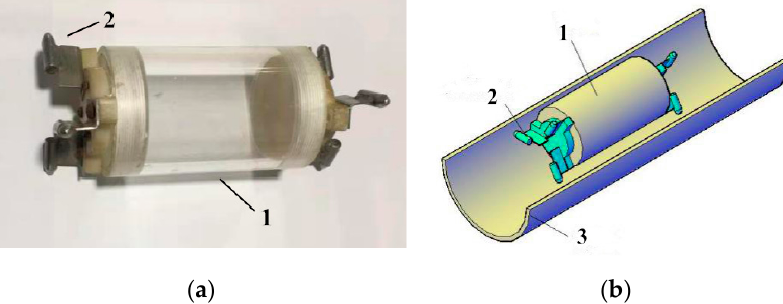
Figure 2. Schematic of pipe vehicle. ( a ) The physical model of the pipe vehicle; ( b ) The geometric model of the pipe vehicle. Note: 1. Barrel. 2. Support body. 3. Pipeline.